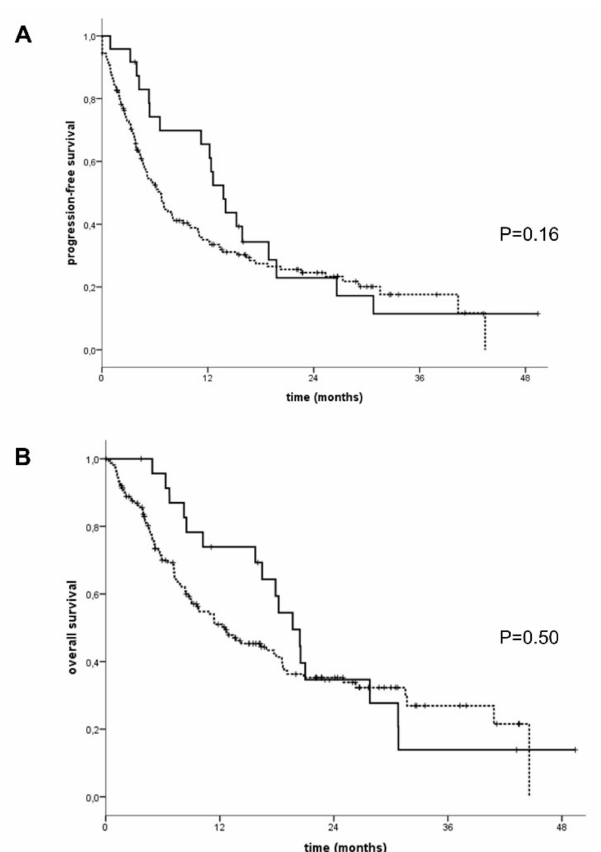
Figure 3. Kaplan–Meyer curves. ( A ) Median progression-free survival (PFS) and ( B ) Overall survival (OS) of metastatic non-small-cell lung cancer (mNSCLC) patients under treatment with PD-1 / PD-L1 immune checkpoint inhibitors who showed (continuous line) or not (dashed line) radiological signs of IRP. Curves show a not statistically significant trend of longer PFS and OS in patients who present IRP compared to the others, respectively (PFS; 13.8 (95% CI: 11.2–16.3) vs. 6.7 (95% CI: 5.3–8.1) months, P = 0.16. OS; 19.7 (95% CI: 16.0–23.3) vs. 12.6 (95% CI: 7.8–17.4) months; P =